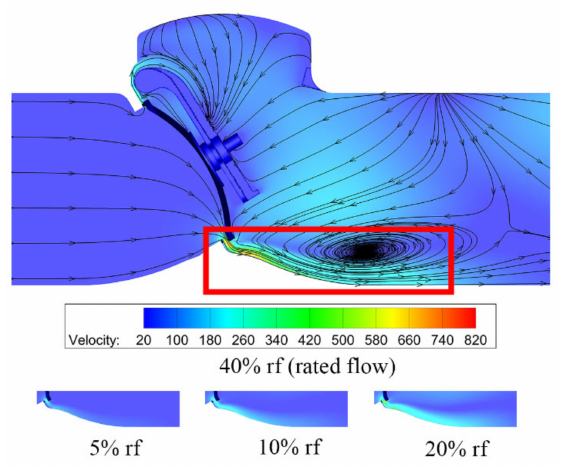
Figure 4. Velocity distributions under di ff erent mass flow